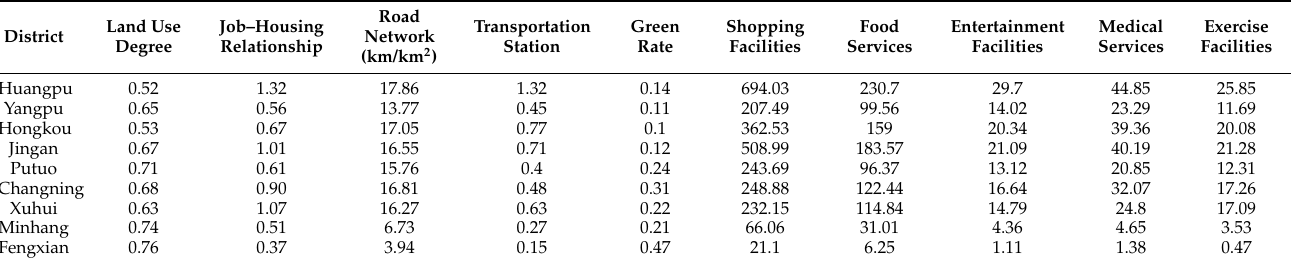
Table 6. Built environment